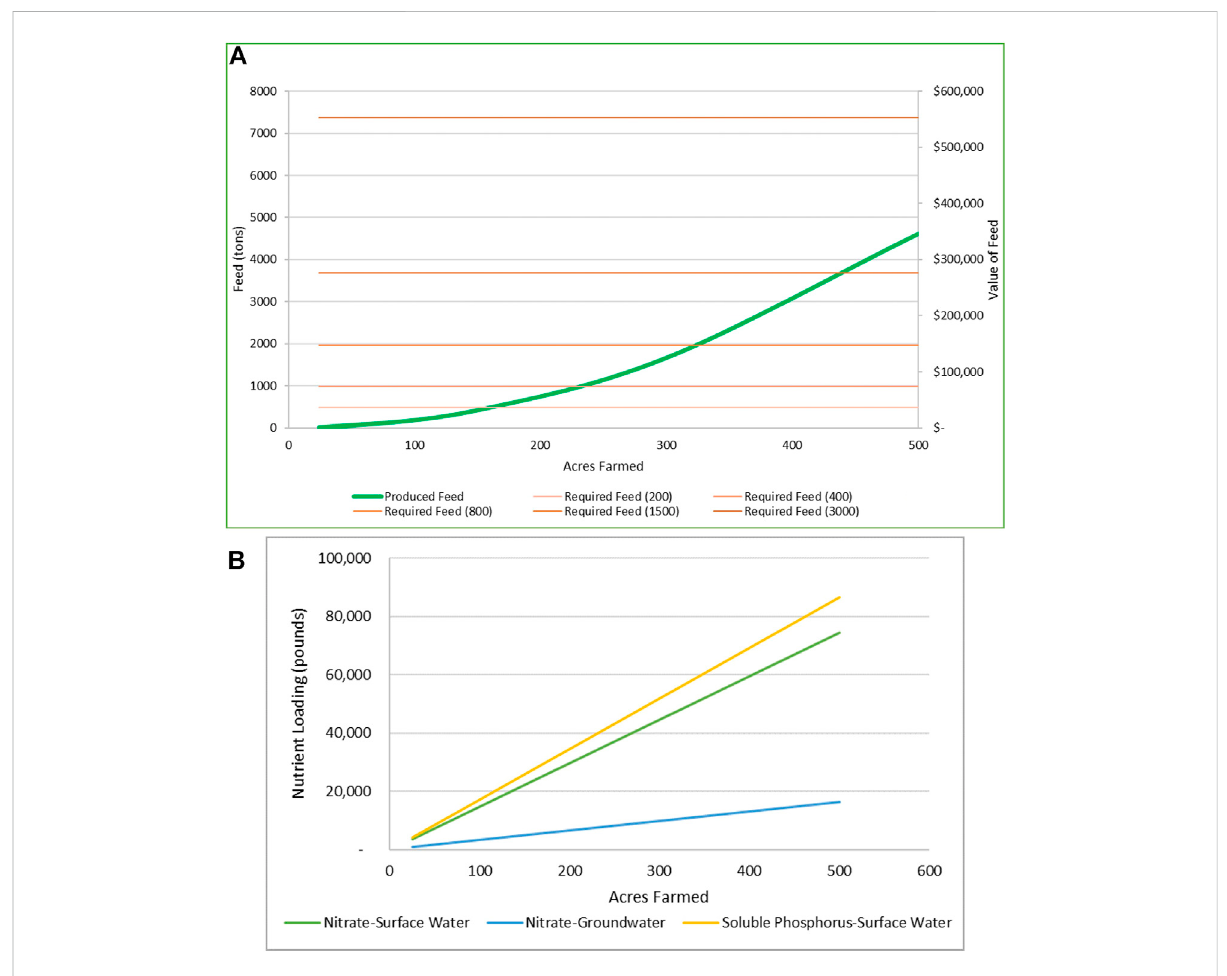
FIGURE 9 Thresholds of feed required (A) and nutrient loading (B) for dairy sizes and produced feed at various acres